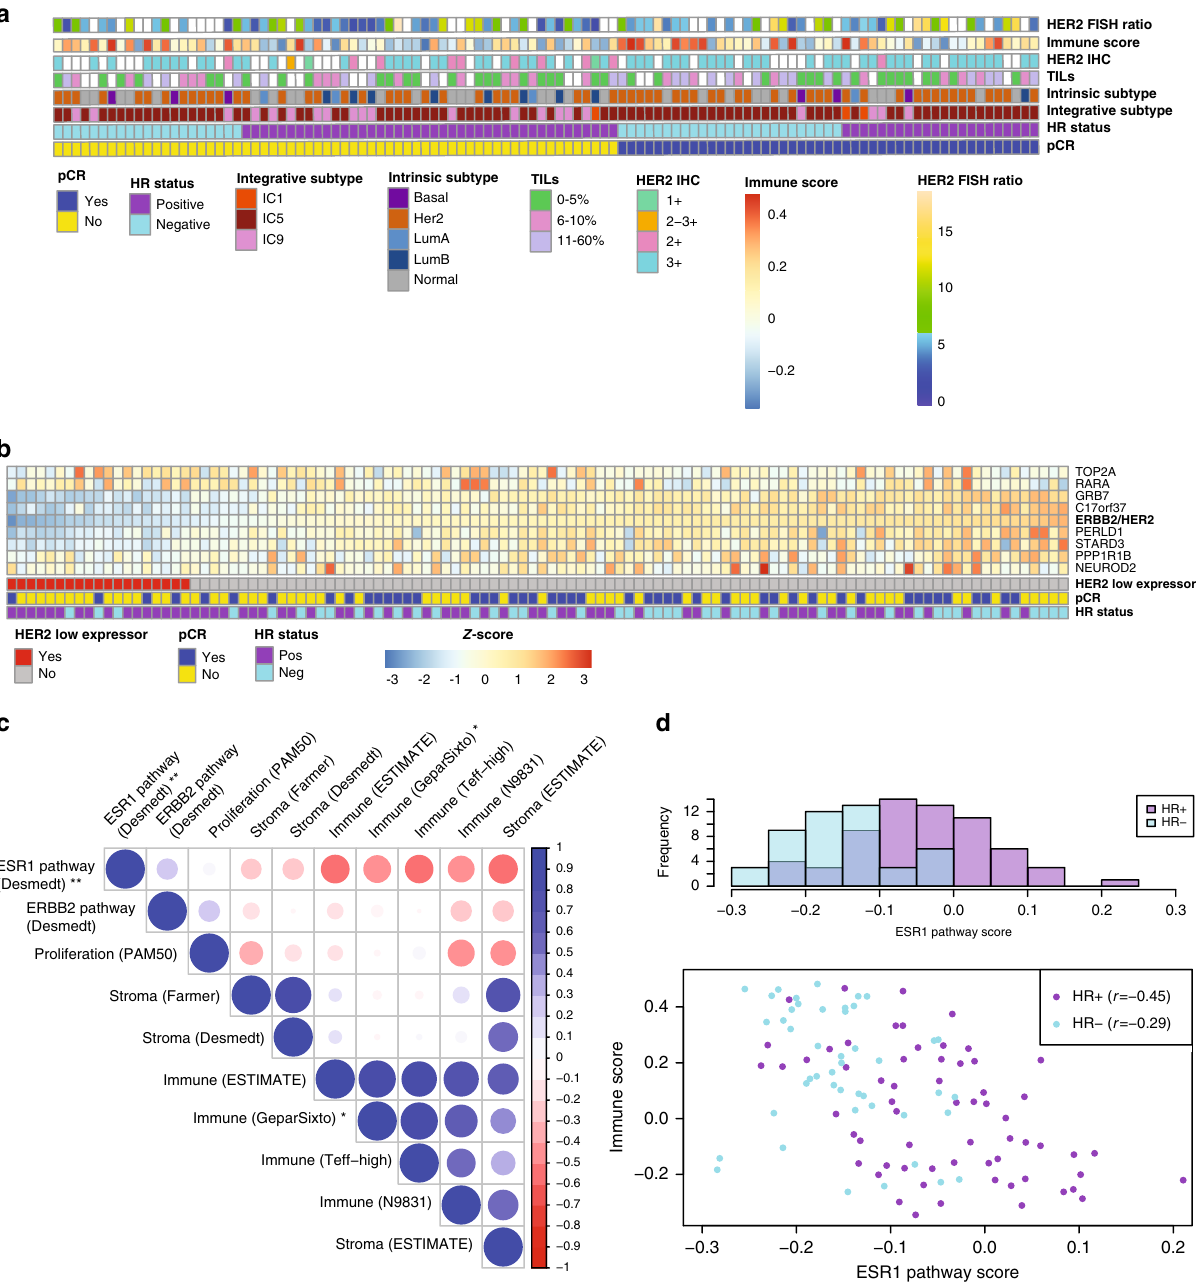
Fig. 2 Characteristics of the cohort prior to treatment. a Selected clinical and expression characteristics and tumor subtypes across the cohort. White squares re fl ect missing data. b Expression values of selected genes within the HER2 amplicon. c Pearson correlation coef fi cient matrix of key gene expression signatures. * P = 0.010 and ** P = 0.012 for correlation with pCR (two-sided Wald test). d Distribution of ESR1 pathway gene expression scores (from ref. 39 ) by HR subtype (top) and their correlation with immune scores (from ref. 33 ) (bottom). FISH: fl uorescent in situ hybridization; IHC: immunohistochemistry; TILs: tumor-in fi ltrating lymphocytes; HR: hormone receptor; pCR: pathologic complete response; IC; integrative subtype/integrative